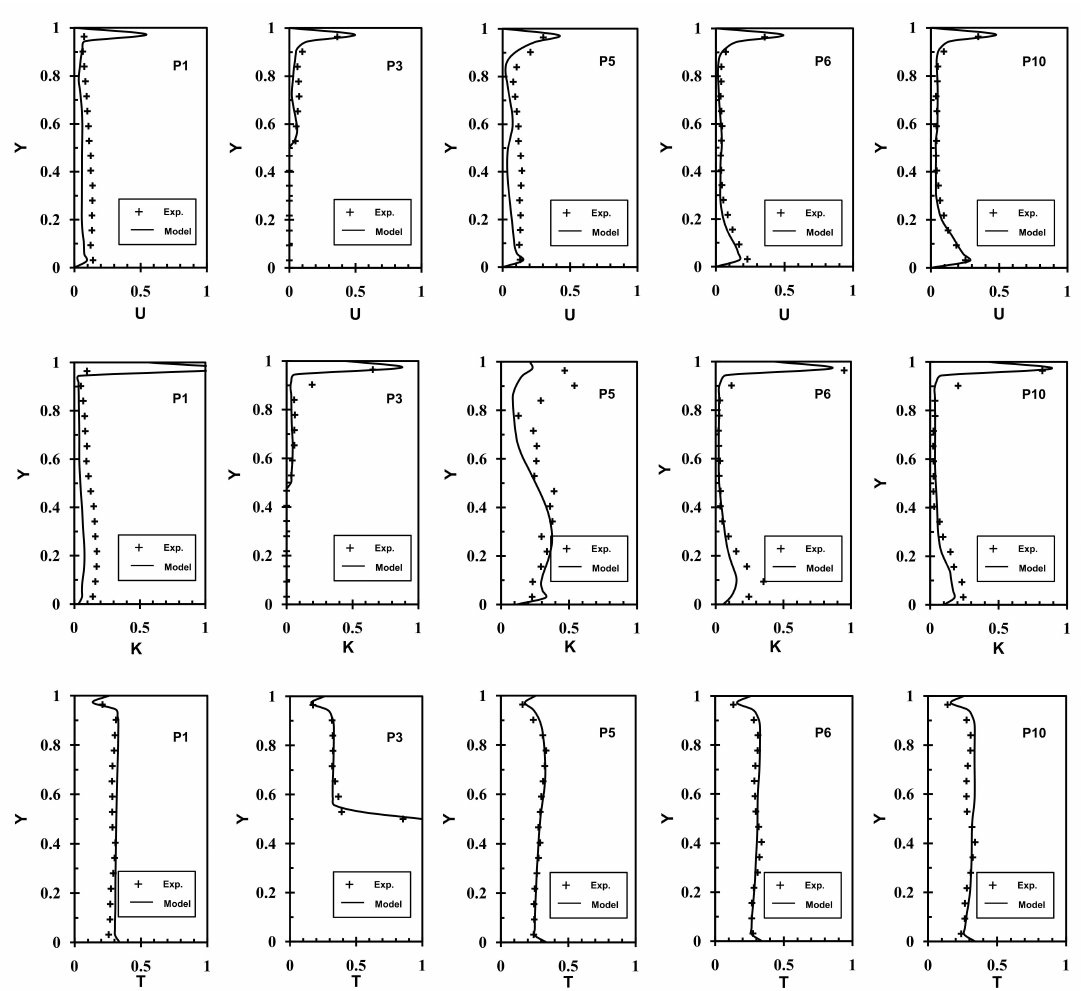
Figure 6. Comparison of normalized velocity, turbulence kinetic energy and temperature profiles at monitoring points 1, 3, 5, 6 and 10 for case